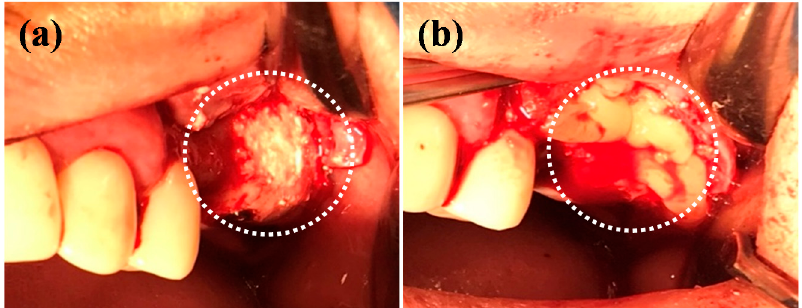
Figure 2. ( a ) Application of α -calcium sulfate hemihydrate ( α -CSH) bioceramic bone graft substitute in a lateral window and ( b ) covered by a concentrated growth factor (CGF)